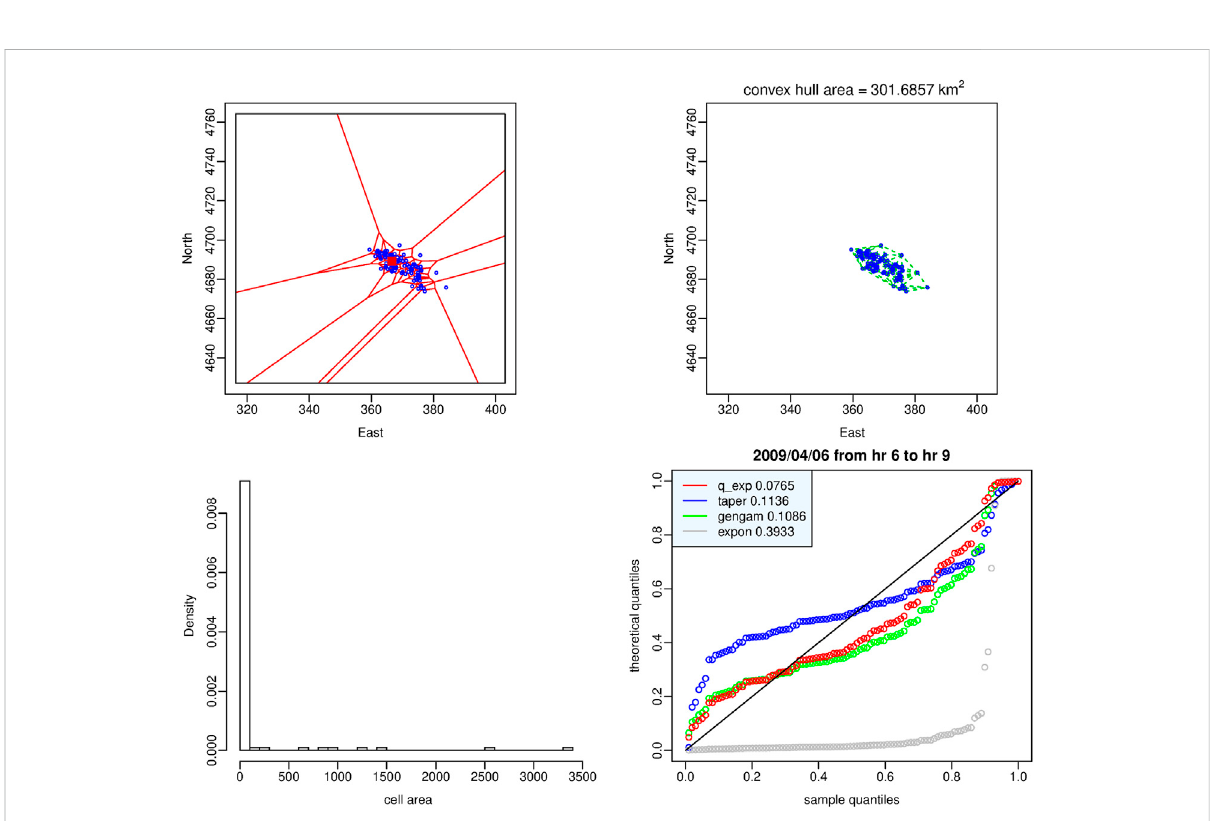
FIGURE 4 Dataset of the time window in which the q -exponential distribution provides the best fi t. Top: Voronoi tessellation (left-hand panel) and Delaunay triangulation (right-hand panel). Bottom: histogram of the cell areas (left-hand panel) and Q-Q plot of the four probability distributions (right-hand panel). Red square indicates the epicenter of L ’ Aquila